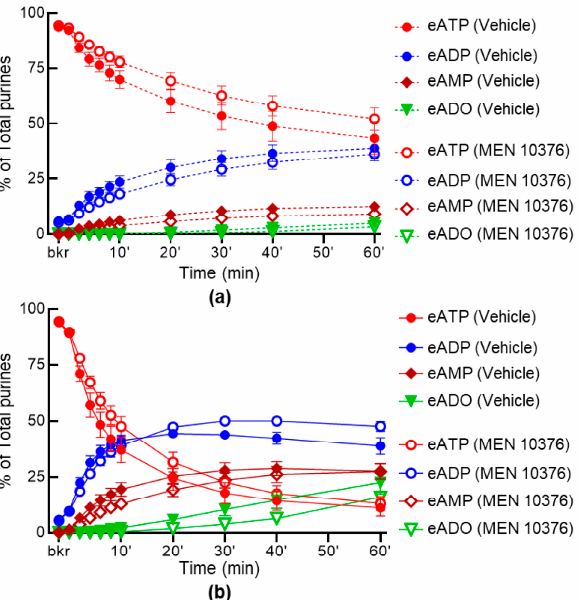
Figure 8. Effect of MEN 10376 on the hydrolysis of eATP by s-ENTDs released in cELS of detrusor- free bladder preparations. Changes in eATP, eADP, eAMP and eADO in the presence of vehicle (DMSO 0.1%, n = 7) in nondistended ( a ) and distended ( b ) bladder preparations in the presence of MEN 10376, 10 µM ( n = 4); n , number of bladder preparations. eATP, eADP, eAMP and eADO are presented as percentages of total purines (eATP + eADP + eAMP + eADO) present in reaction solutions. p > 0.05 at all time-points of reaction in the presence of drug. Two-way ANOVA with Sidak’s multiple comparisons tests.